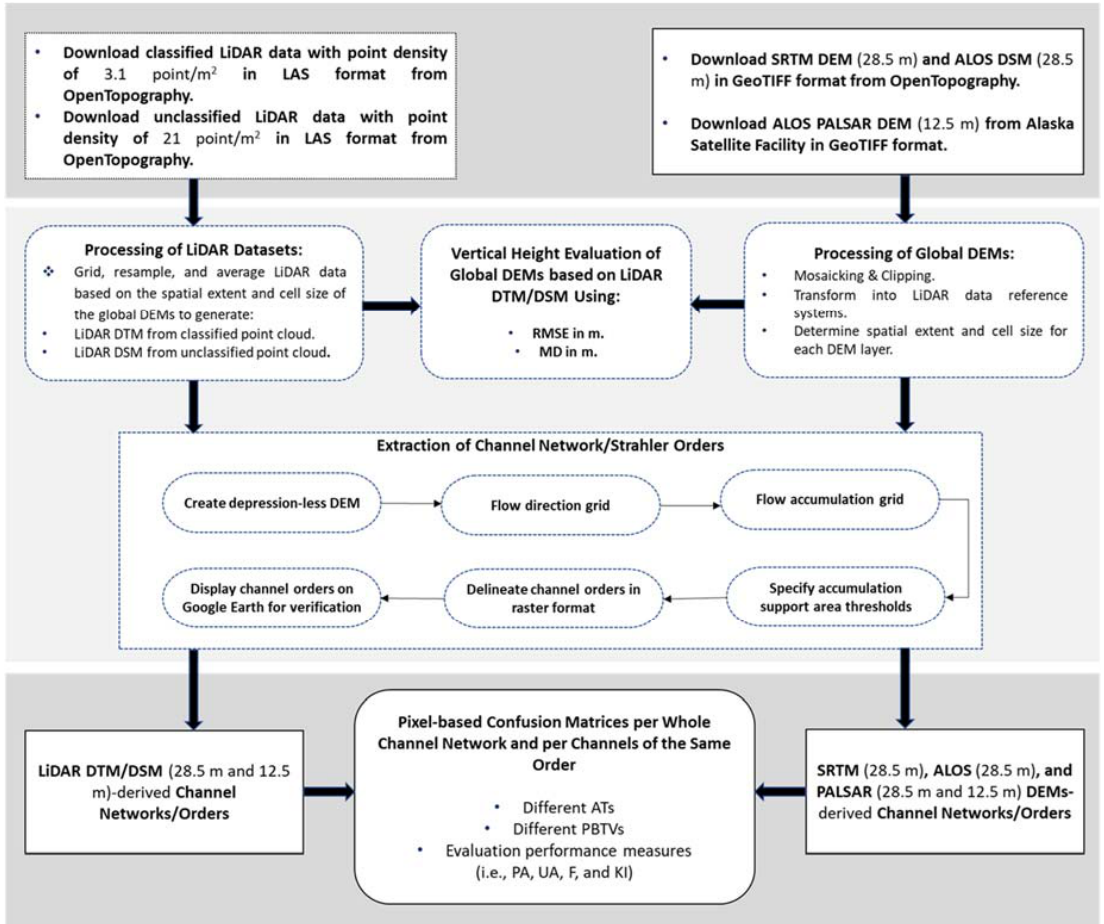
Figure 2. Methodology flow chart for the per ‐ pixel geometric evaluation of channel networks/Strahler orders.